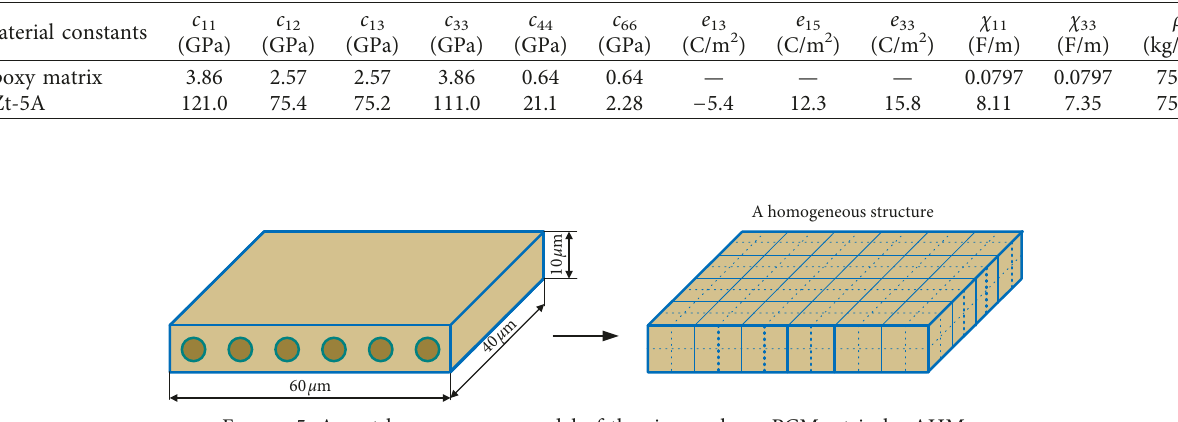
Figure 5: A part homogeneous model of the singer-player PCMs strip by AHM.